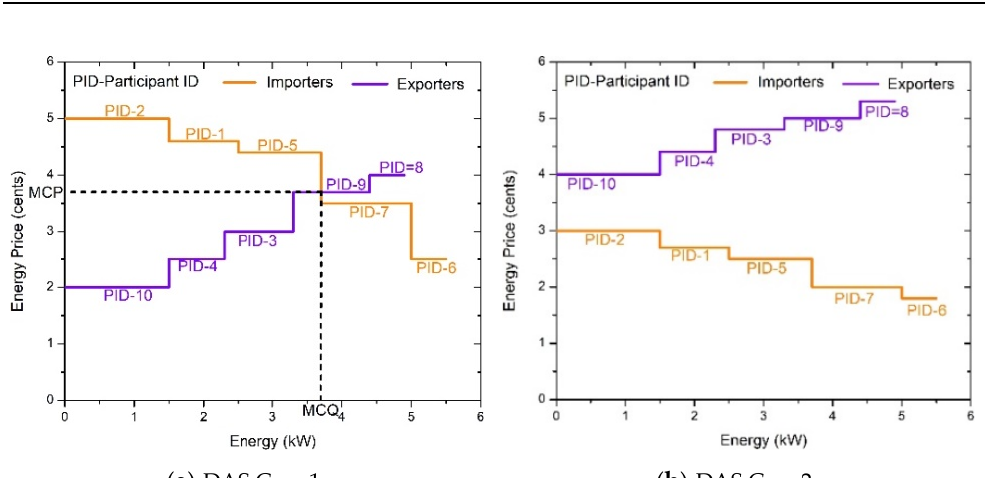
Figure 10. P2P energy market-clearing with DAS technique. Figure 9. Participant daily electricity bill under P2G and P2P paradigms. Table 1. Participants’ quoted demand and price for P2P energy market.